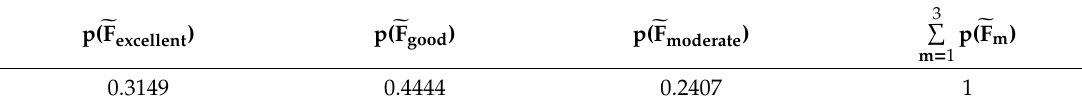
Table 13. Fuzzy membership values and probabilities.